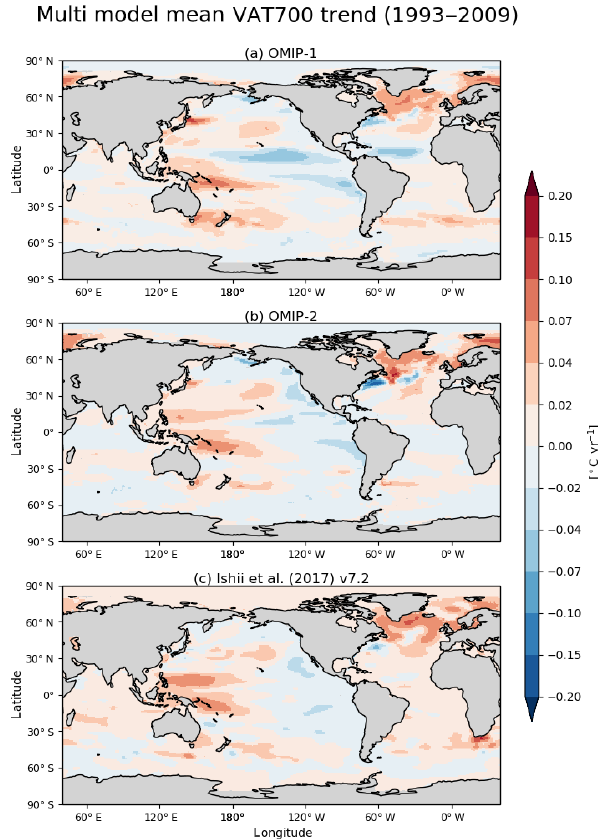
Figure 26. Multi-model mean 17-year (1993–2009) trend of up- per 700m temperature ( ◦ Cyr − 1 ). (a) OMIP-1, (b) OMIP-2, and (c) Ishii et al. (2017) v7.2. See Figs. S47 and S48 for the behavior of individual